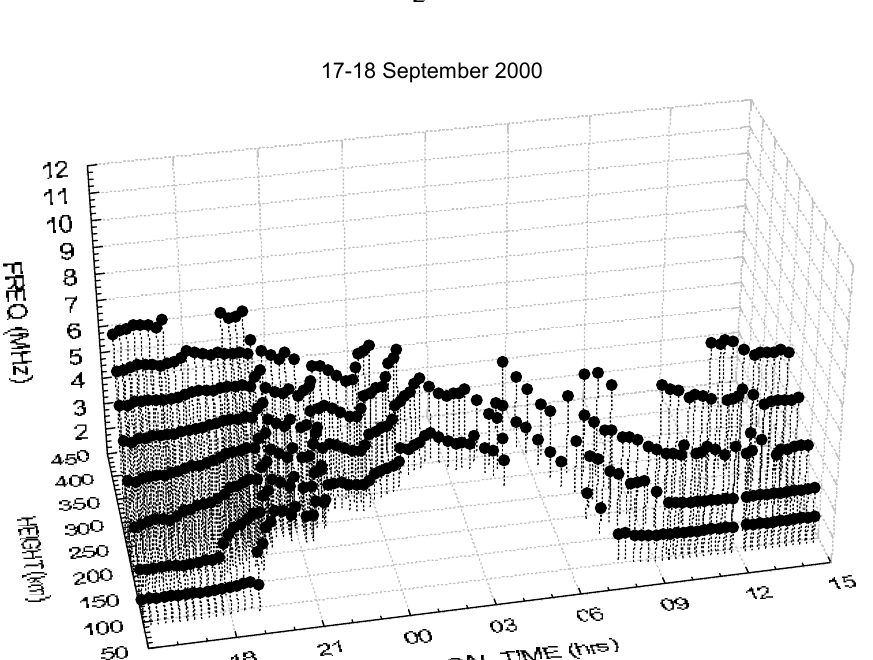
Fig. 6. The 3-D plot of the height vari- ation for plasma frequencies 2–12MHz versus the local time for the night hours between 13 and 14 October 2000. Ion- isation enhancement was observed over Athens.